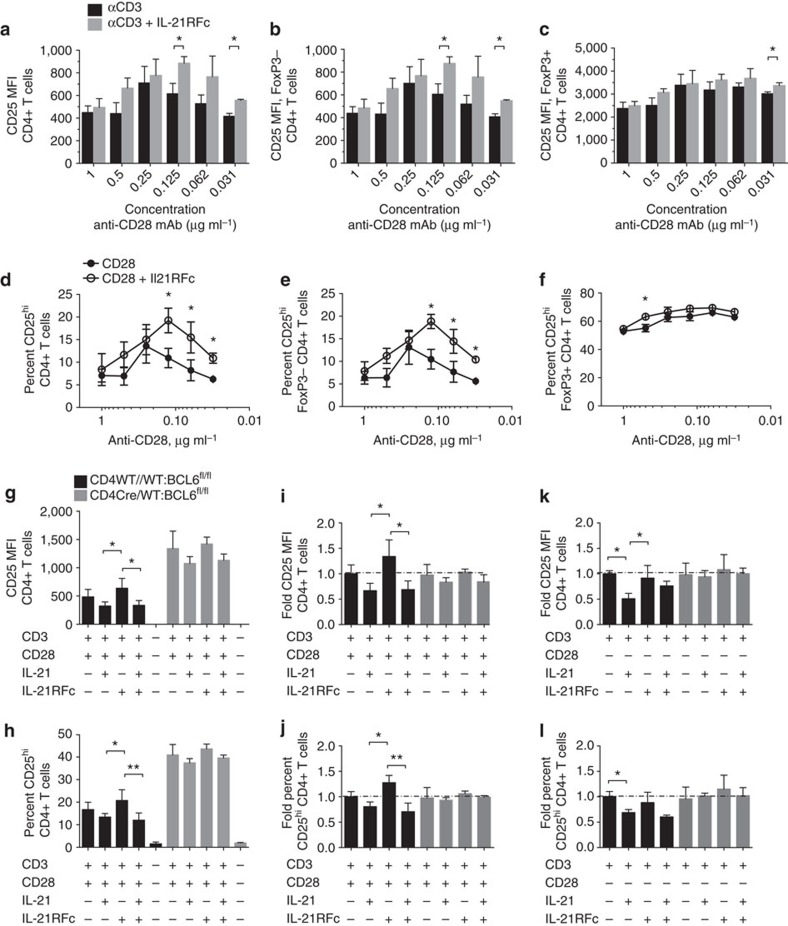
Bcl-6 inhibits CD25 and IL-21 modulates CD25 through Bcl-6.CD4+ T cells from the spleen of C57BL/6 mice were cultured ex vivo in the presence of anti-CD3 monoclonal antibody and decreasing concentrations of anti-CD28 monoclonal antibody, in the presence or absence of IL-21 neutralization (IL-21RFc) for 3 days. Bar graphs showing the immunofluorescence intensity (MFI) of the expression of CD25 on (a) TCRβ+CD4+ T cells (b) Foxp3− TCRβ+CD4+ T cells and (c) Foxp3+ TCRβ+CD4+ T cells in the presence (grey bars) or absence (black bars) of 5 μg ml−1 of IL-21RFc. The percentages of CD25-expressing (d) TCRβ+CD4+ T cells, (e) Foxp3− TCRβ+CD4+ T cells and (f) Foxp3+TCRβ+CD4+ T cells. Data are shown as the means ±s.d. of triplicate samples from a representative of two experiments with similar results. P-values were calculated by Student's t-test where *P<0.05. Bcl-6 inhibits CD25 expression on CD4+ T cells: CD4+ T cells were purified from mice in which Bcl-6 was conditionally deleted in CD4+ T cells (CD4Cre/WT:BCL6fl/fl) and Bcl-6-sufficient littermates (CD4WT/WT:BCL6fl/fl). Quantification of (g) the mean fluorescence intensity (MFI) of CD25 and (h) percentage of cells expressing high amounts of CD25 in Bcl6-sufficient (black bars) and Bcl6-deficient (grey bars) CD4+ T cells cultured in the presence of soluble anti-CD3 and anti-CD28 monoclonal antibodies and in the presence or absence of recombinant murine IL-21 and IL-21RFc. (i) Fold change of MFI relative to the mean value (dotted line) of CD4+ T cells stimulated with anti-CD3 and anti-CD28 monoclonal antibodies alone and (j) percentages of CD25-expressing CD4+ T cells. CD4+ T cells stimulated with anti-CD3 showing (k) fold change from the mean MFI (dotted line) and (l) percentages of CD25-expressing cells. Data are shown as the means ±s.d. of triplicate samples from a representative of two experiments with similar results. P-values were determined by one-way analysis of variance where significant differences between groups are shown as *P<0.05 and **P<0.01.